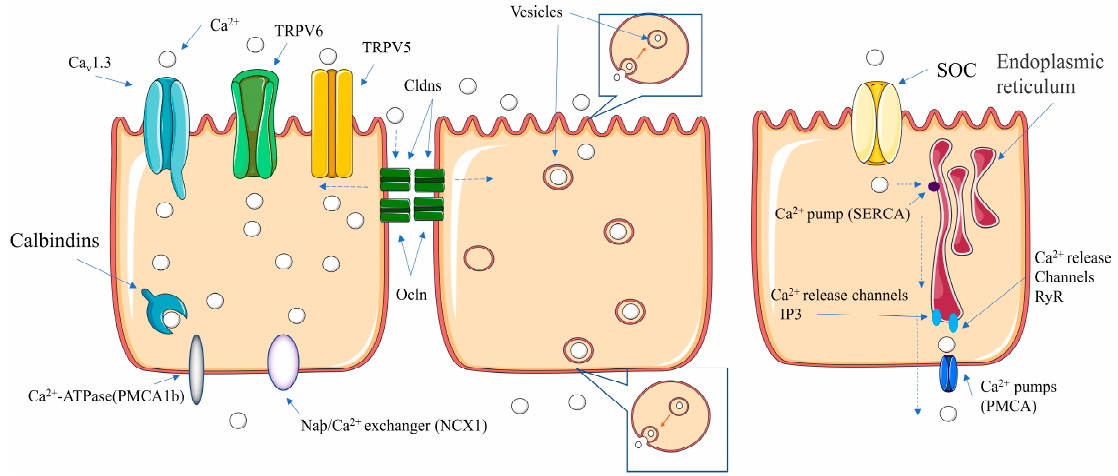
Figure 2. Absorption pathways of calcium ions in the